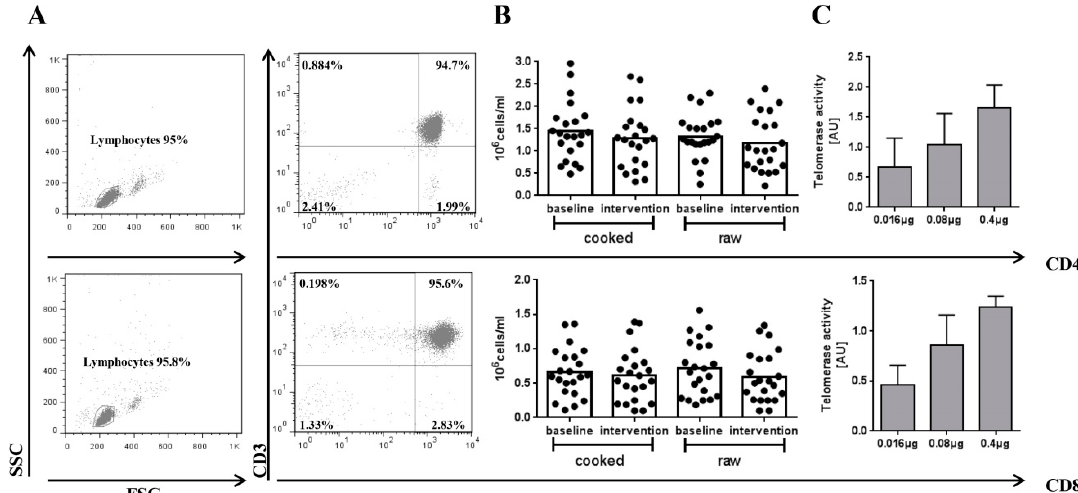
Figure 2. ( A ) Purity of CD4+ and CD8+ T cell subsets and titration of telomerase activity. A forward scatter/side scatter (FSC/SSC)-plot was made and all lymphocytes were gated. The lymphocyte population was copied to a CD3+/CD4+- or CD3+/CD8+-scatterplot identifying specific T-cell subsets. ( B ) Number of CD4+/CD8+ T cells in 1 mL of blood. ( C ) Titration of isolated CD4+/CD8+ T cells was done using the TRAP-ELISA assay. Bars are means + SD, n ≥ 3.